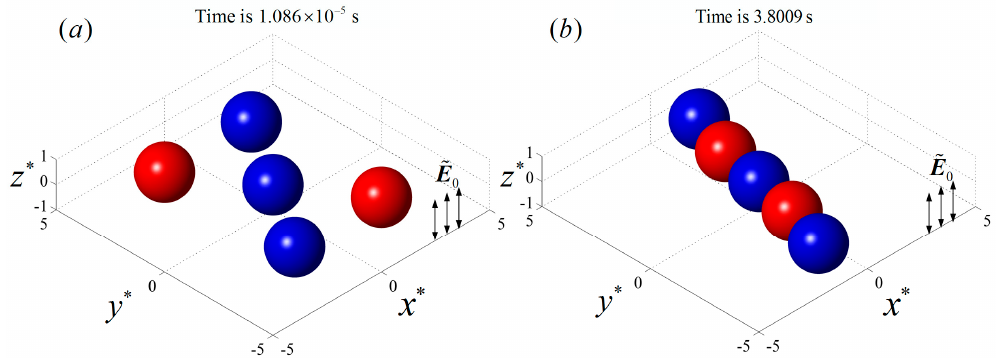
Figure 7. The DEP interaction of five particles with same properties and initial positions as Figure 4, except the conductivities of particle 2 and particle 4 ( σ p 2 = σ p 4 = 6 × 10 − 3 S/m) are on a plane perpendicular to a uniform AC electric field with (cid:101) E 0 = 0.02 and f = 10 3 Hz. ( a ) The initial positions of the particles; ( b ) the final line-styled particle chain with alternately arranged pDEP and nDEP particles. The blue and red colors denote pDEP and nDEP particles, respectively.